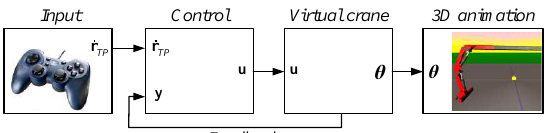
Figure 13: Overview of the simulation. crane, as shown in Figure